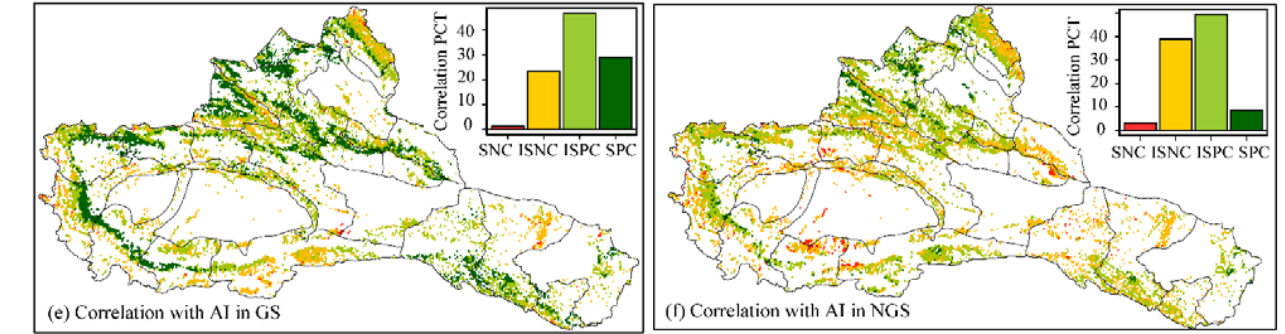
Figure 7. Mean ( a , c ), trends ( b , d ), and detrended correlations ( e , f ) between the Normalized Difference Vegetation Index (NDVI) and aridity index (AI) in the arid region of northwestern China (SD, significantly decreasing trend; ISD, non-significant decreasing trend; ISI, non-significant increasing trend; SI, significantly increasing trend; SNC, significantly negative correlation; ISNC, non-significant negative correlation; ISPC, non-significant positive correlation; SPC, significantly positive correlation; GS, growing season; NGS, non-growing season).